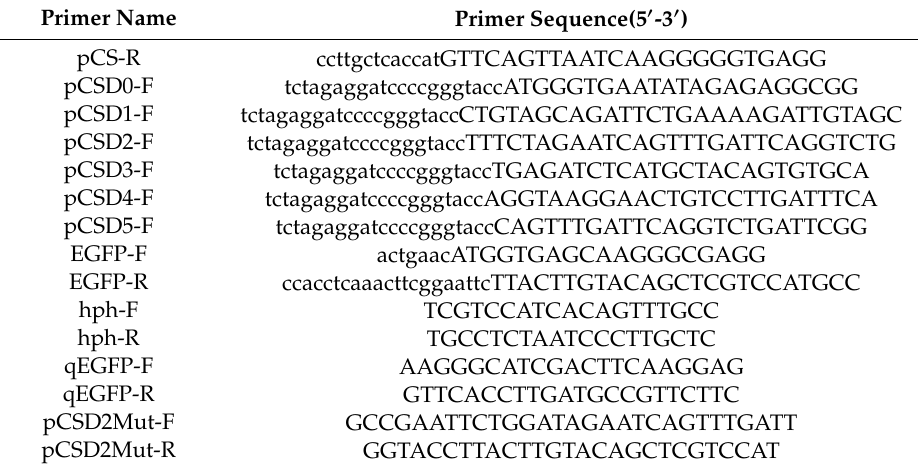
Table 3. Sequence of the